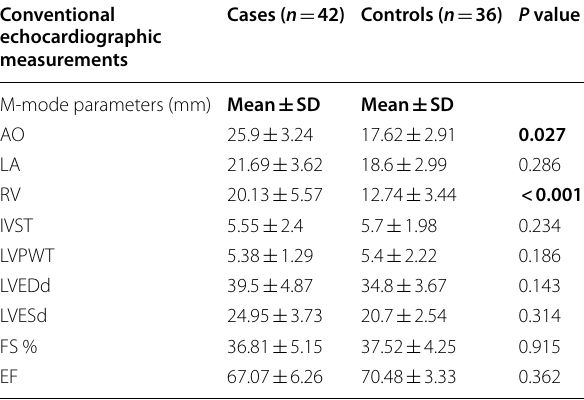
Table 2 M-mode measurements of patients and controls